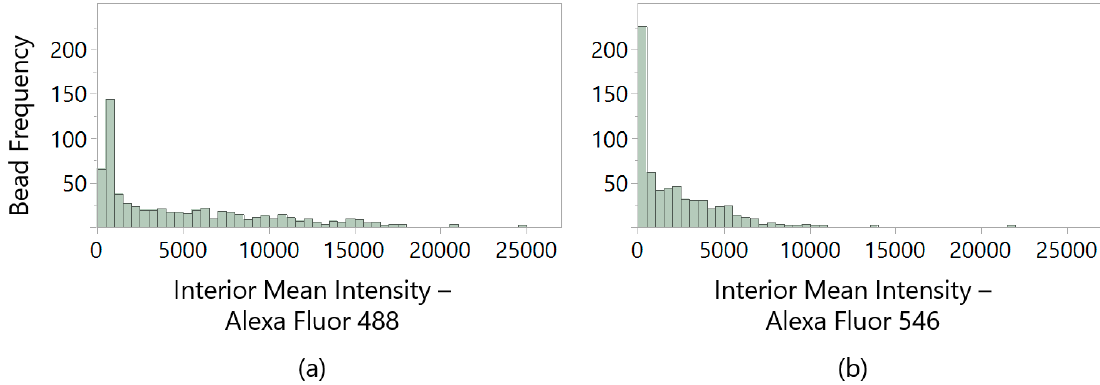
Figure 2. Distribution of interior mean intensities for a one-bead-one-compound combinatorial peptide library incubated with Alexa Fluor 488-labeled polyclonal human immunoglobulin G (IgG) and Alexa Fluor 546-labeled CHO-S host cell proteins (HCP). ( a ) shows the interior mean fluorescent intensity with the ClonePix 2 FITC filter at 800 ms exposure to detect the labeled IgG. ( b ) shows the detected distribution from the ClonePix 2 Rhodamine filter at 500 ms exposure for HCP detection. Interior mean intensities were calculated from imaging data collected by the ClonePix 2 software for all image features not excluded as irregular by the software algorithm.